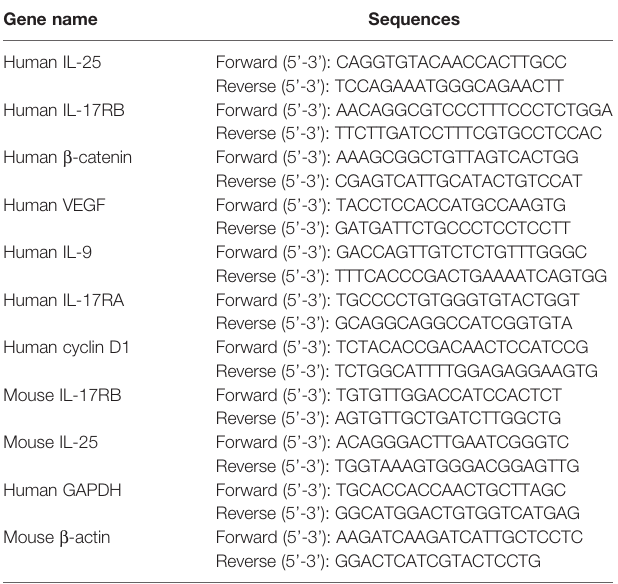
TABLE 1 | The sequences of primer pairs used in